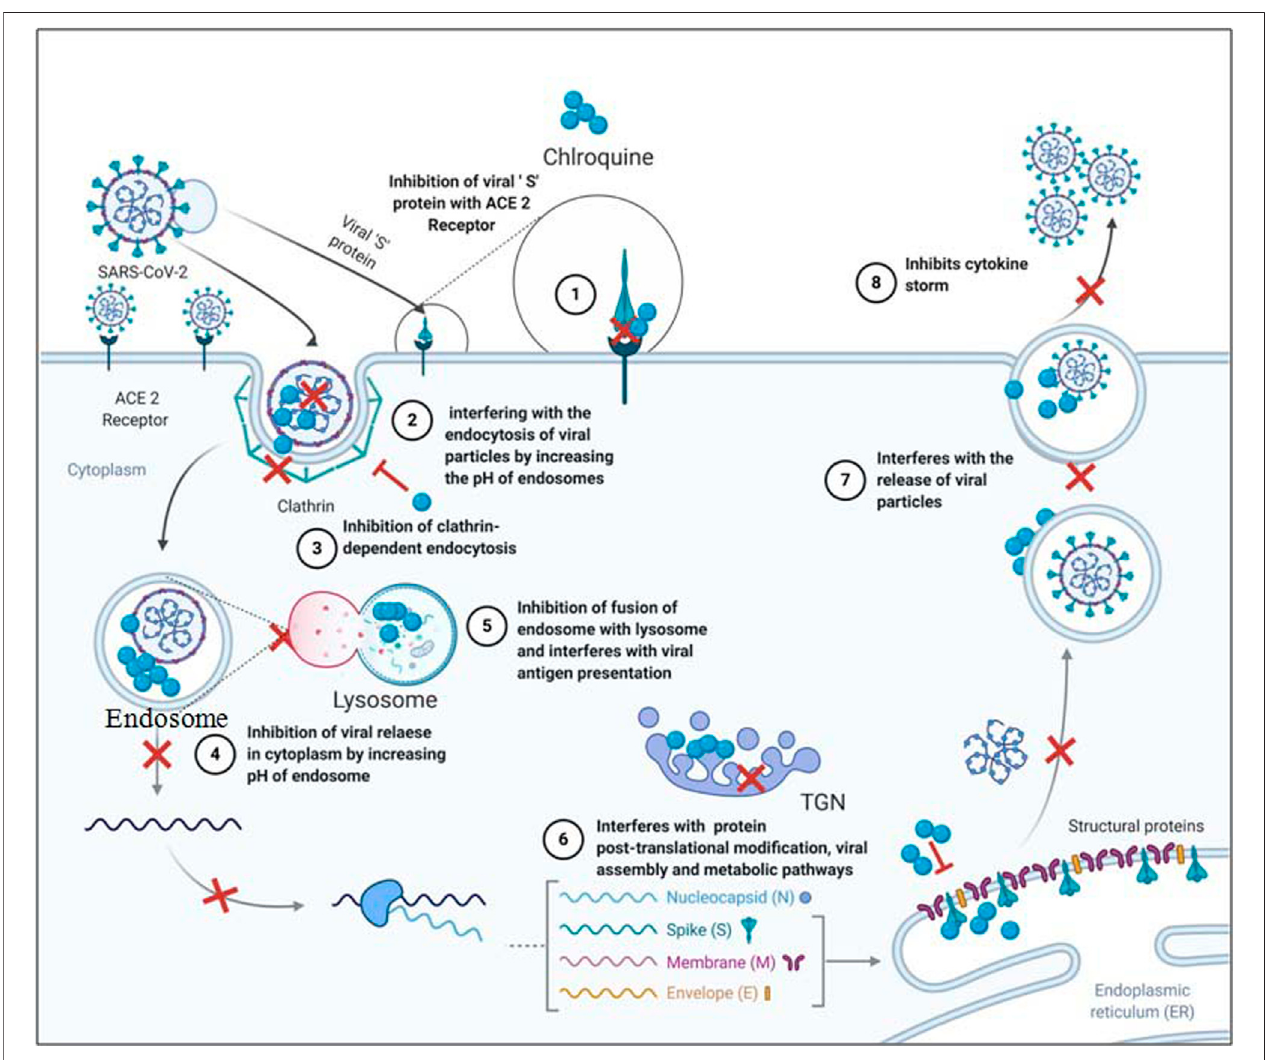
FIGURE 3 | Probable mechanism employed by chloroquine to inhibit